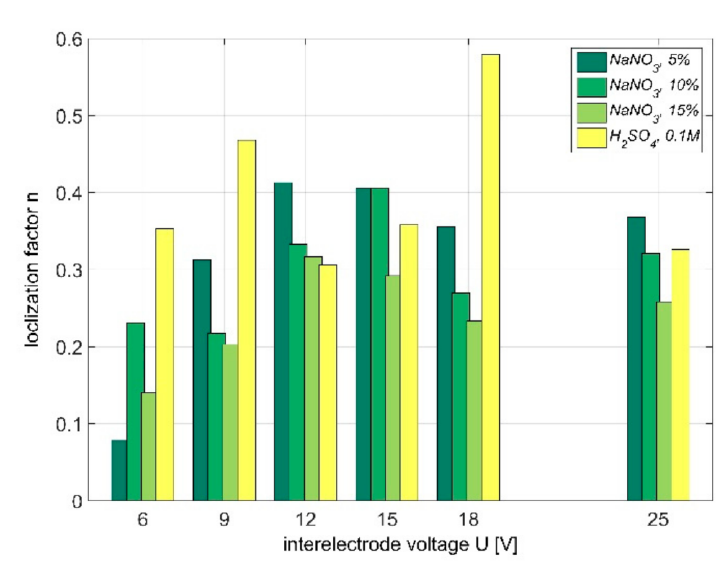
Figure 8. Localization factor n for NaNO 3 and 0.1 M H 2 SO 4